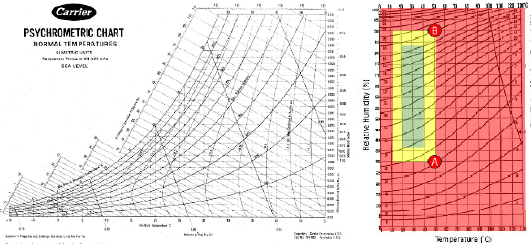
Figure 5. RH drops immediately in a historical temple